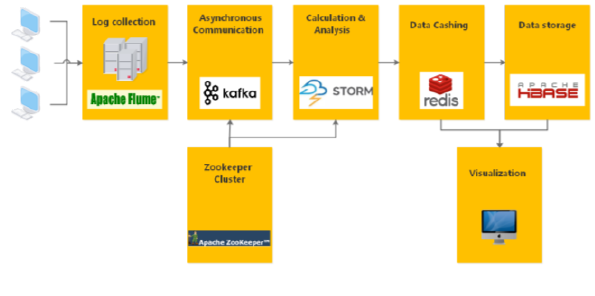
Figure 1. Overall architecture of the